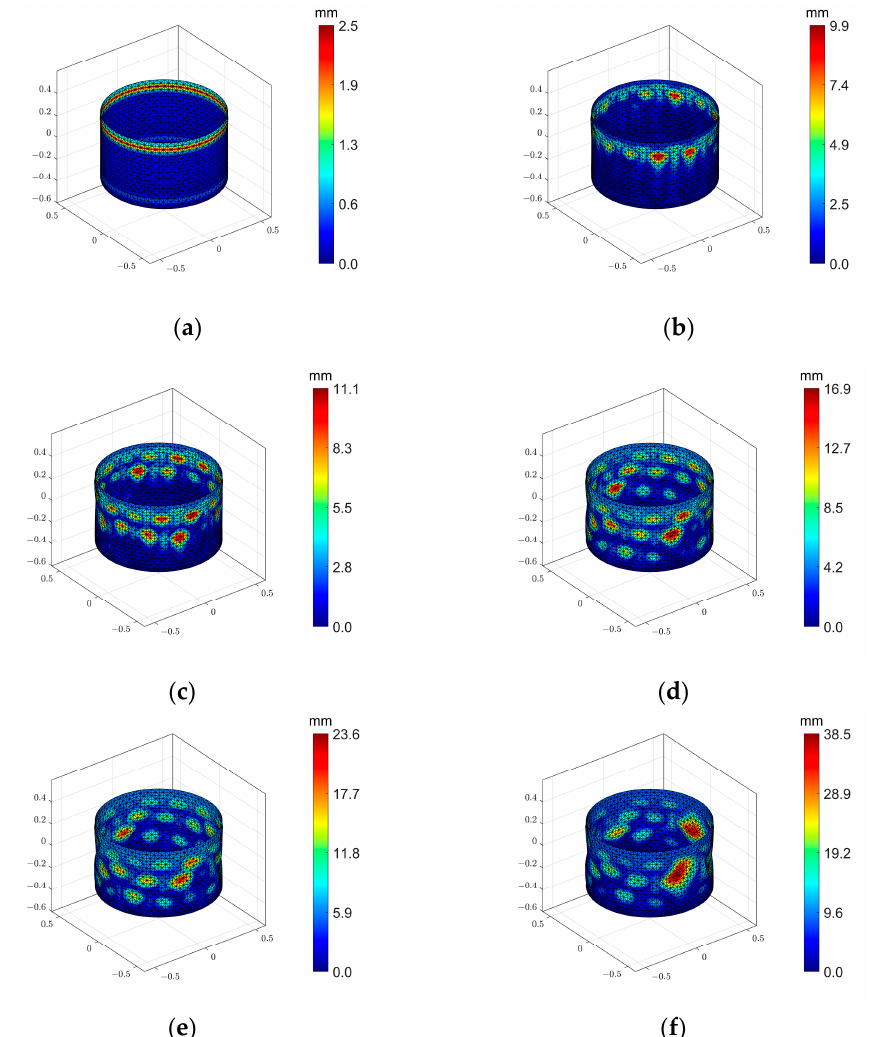
Figure 11. Postbuckling of the overall axial compression: ( a ) before buckling, ( b ) first buckling, ( c ) second buckling, ( d – f ) third buckling.